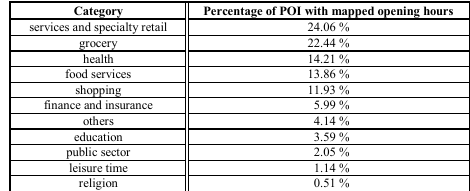
Table 2: Percentage of POIs for each category with mapped opening hours in the research area Category Percentage of POI with mapped opening hours services and specialty